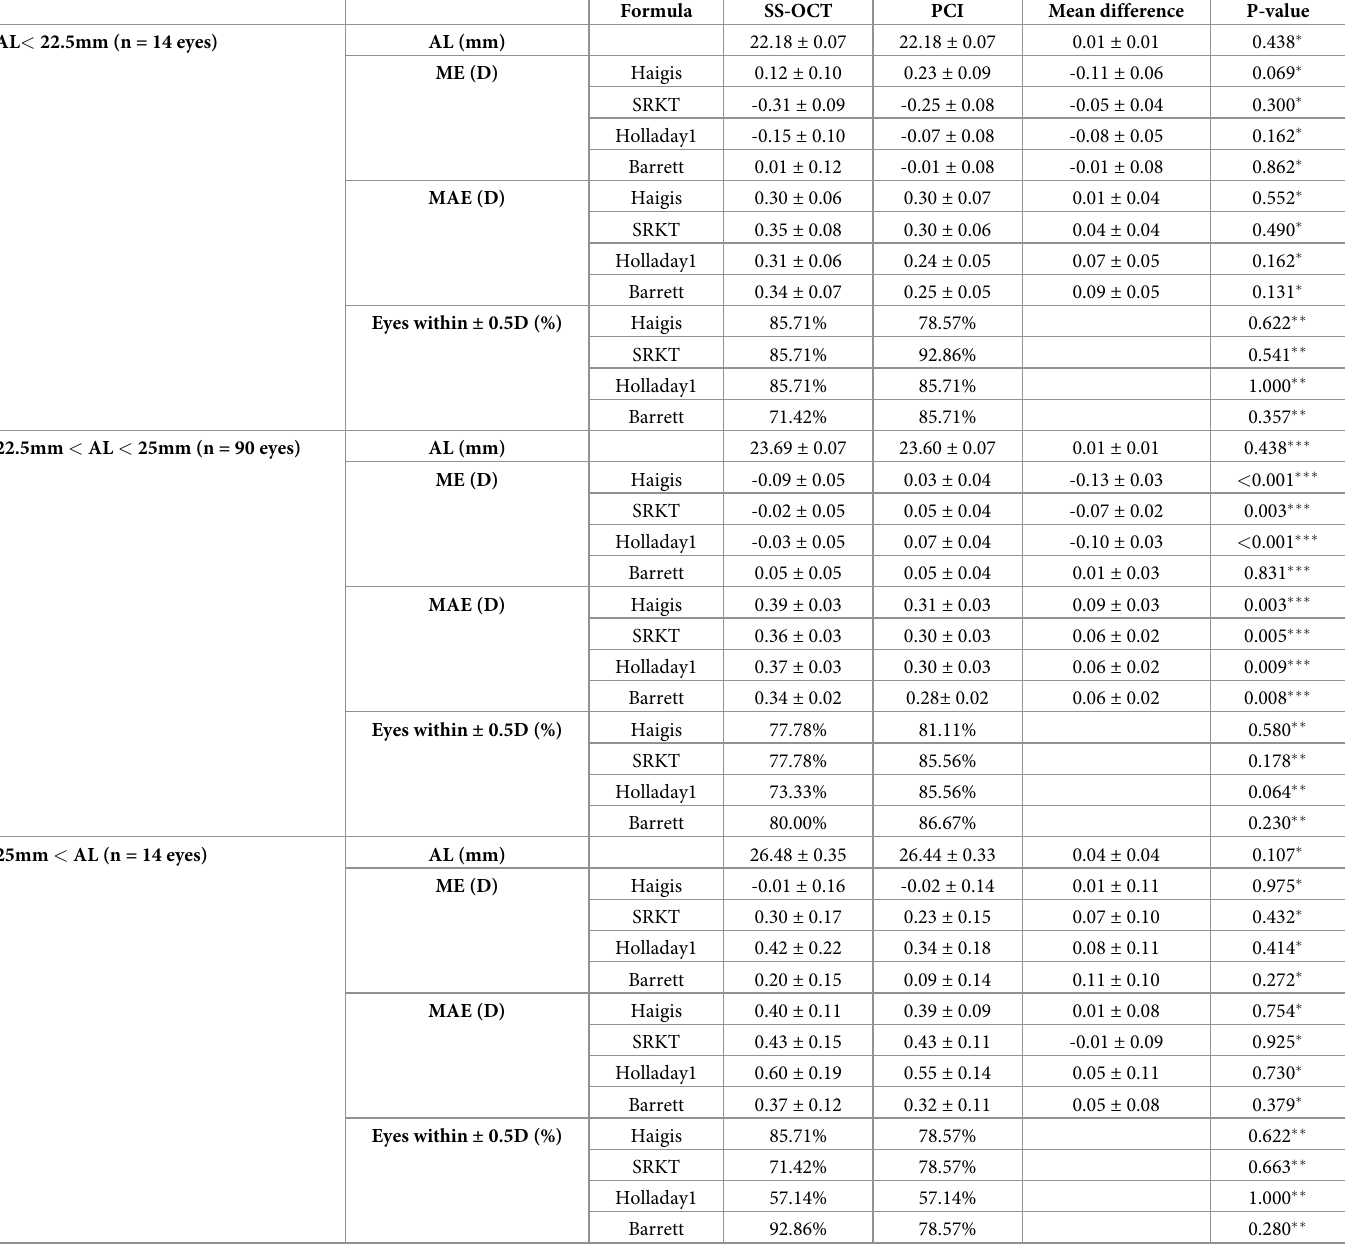
Table 5. Comparison of postoperative refractive errors according to axial length